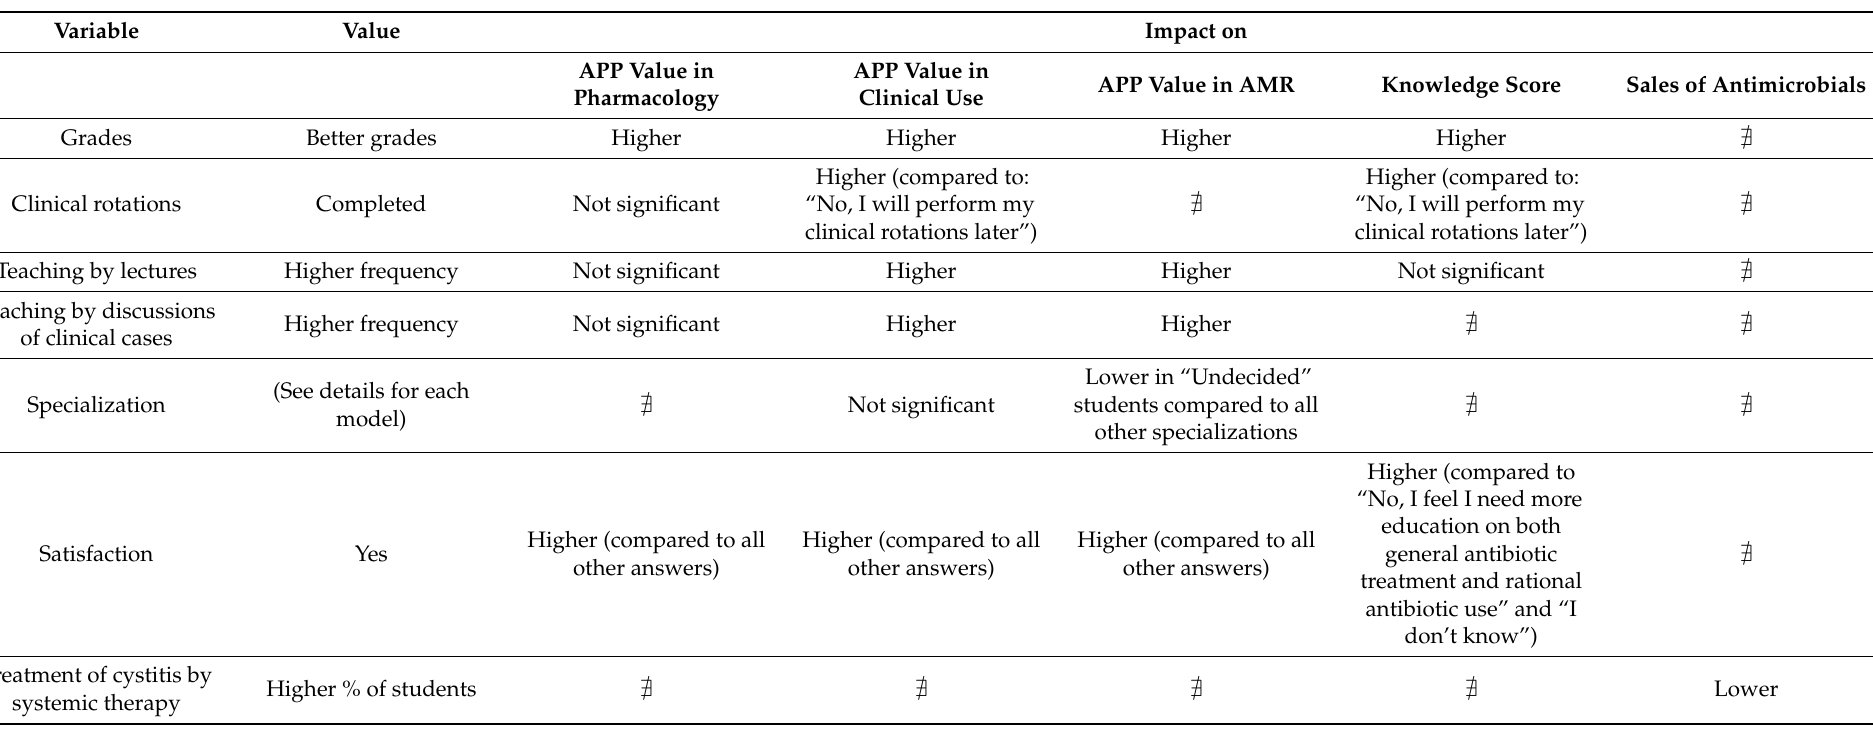
Table 1. Variables with significant ( p < 0.05) impact on the average perception of preparedness (APP) of European veterinary students in the fields of pharmacology of antimicrobial agents, clinical use of antimicrobial agents, and antimicrobial resistance (AMR) based on student-level mixed linear models; impact on students’ knowledge score (calculated as percentage of correct answers given to questions Q14–18, Q21–23 of the survey), based on student-level mixed linear models; and impact on sales of antimicrobial agents based on country-level linear models. Results are corrected for multiple comparisons by the Bonferroni–Holm method. Variables that were not included in one of these four models are indicated by (cid:64) . Variables or values that were not significant in all four models are not included in the